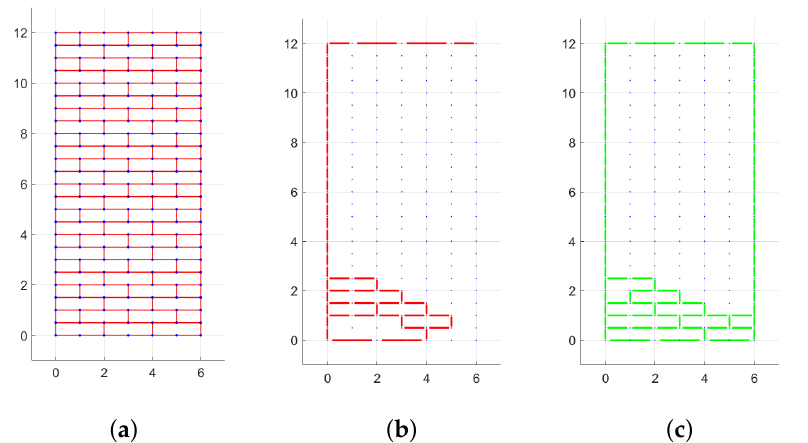
Figure 6. Periodic masonry with H / W = 2: ( a ) texture, ( b ) mortar joints with displacements s (cid:54) = 0 for right oriented force, ( c ) mortar joints with rotations w (cid:54) = 0 for right oriented force. (Dimensions expressed in units.)